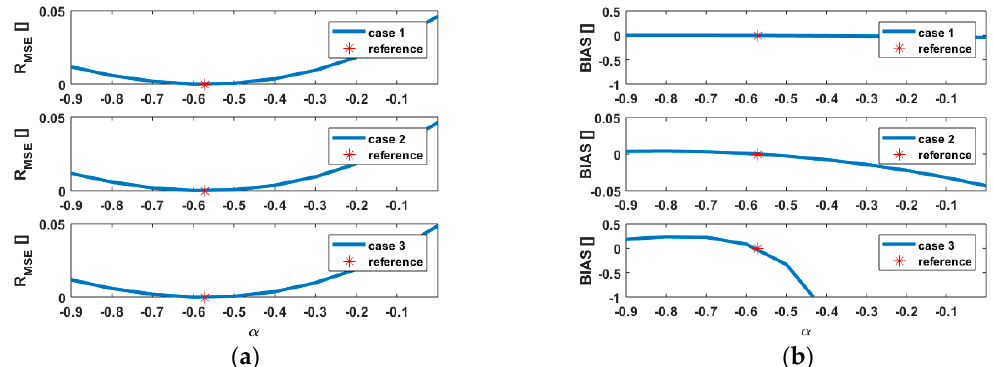
Figure 3. Impact of variations of the power factor α of the intensity-based model for R MSE ( a ) and BIAS ( b ); the three subplots correspond to the three cases of interest: normal (1), low (2) and strong varying intensities (3) respectively. Please note the different scaling for case 3 (bottom b) for the sake of readability.